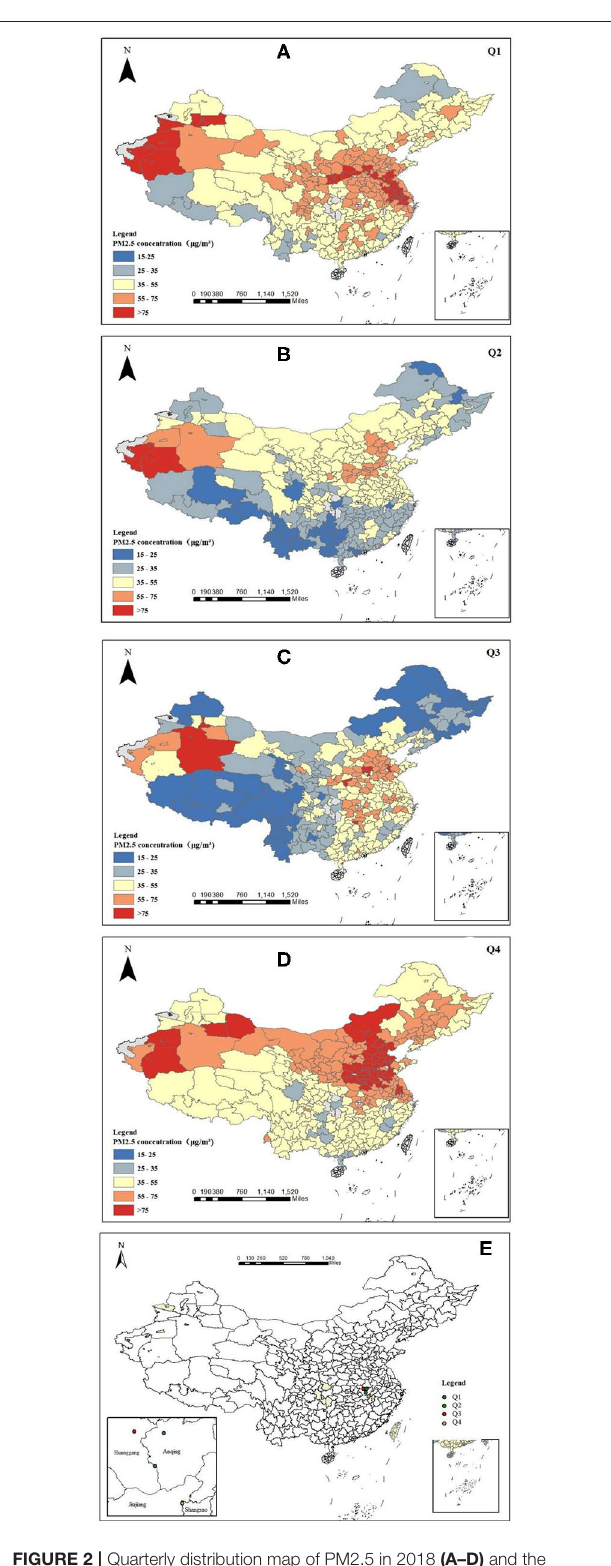
FIGURE 2 | Quarterly distribution map of PM2.5 in 2018 (A–D) and the distribution map of the pollution gravity center in 2018 (E)